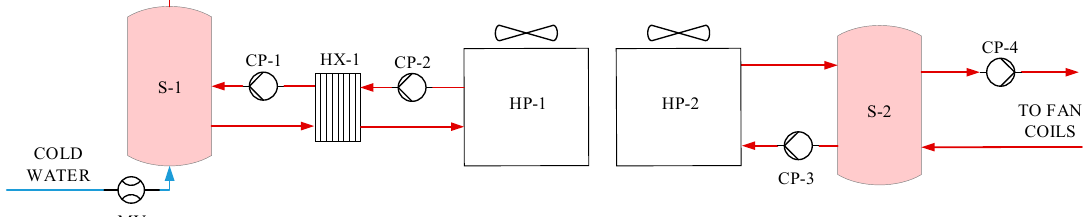
Figure 8. AWHP-1 and AWHP-2—air-to-water heat pump system for DHW heating, space heating and space cooling.